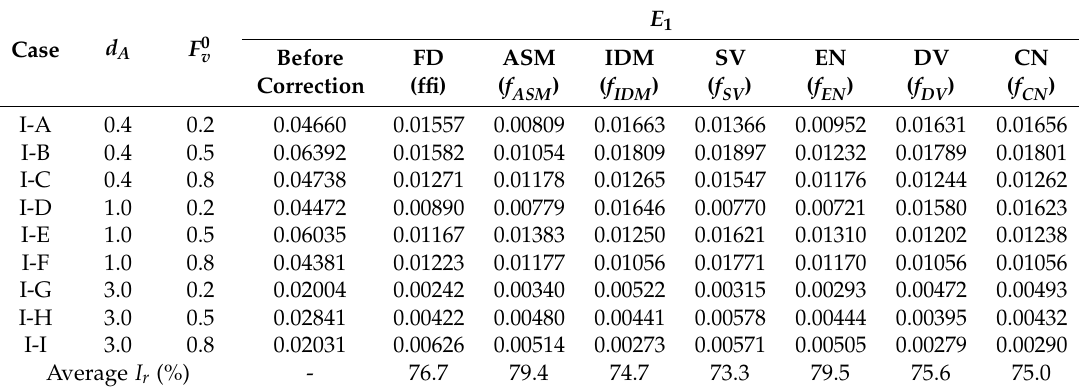
Table 2. Error index ( E 1 ) before and after correction using seven types of texture analysis indices (FD, ASM, IDM, SV, EN, DV, and CN), for Case I (irregularly-shaped particles with Voronoi internal structure), along with the corresponding average improvement rate ( I r